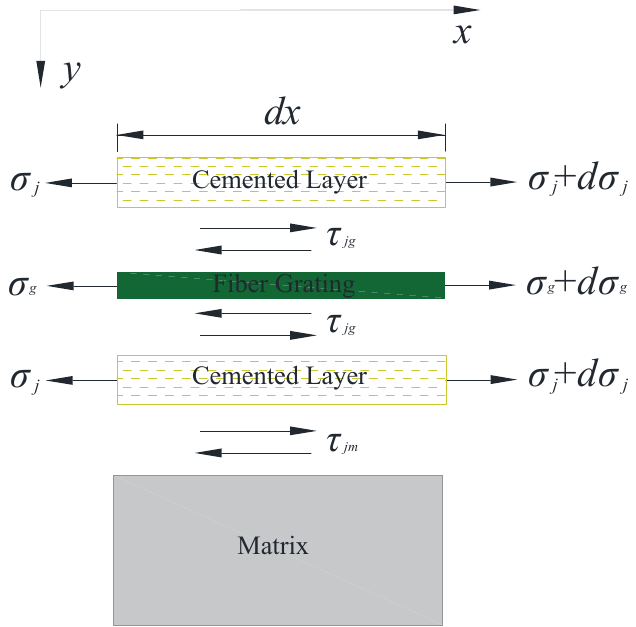
Figure 3. Strain transfer relationship between different media.